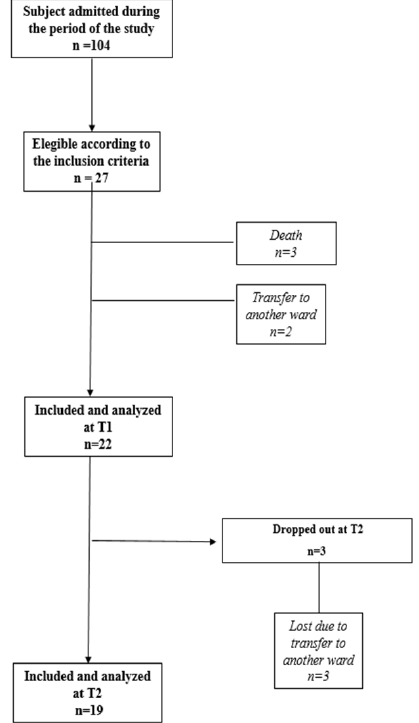
Figure 2. Flow-chart diagram of the study. A total of 27 patients (59.3% males) with a median age of 77.3 years (range 70.1–86.2) Figure 2. Flow ‐ chart diagram of the study . were enrolled according to the inclusion/exclusion criteria; 22 patients were included in the statistical analysis at T1 and 19 in the analysis at